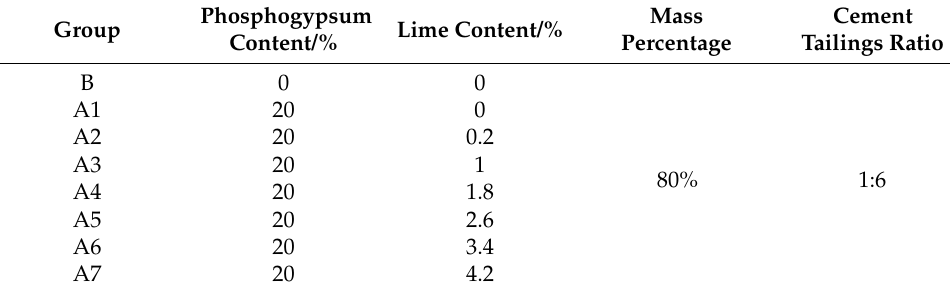
Table 4. Mix weight